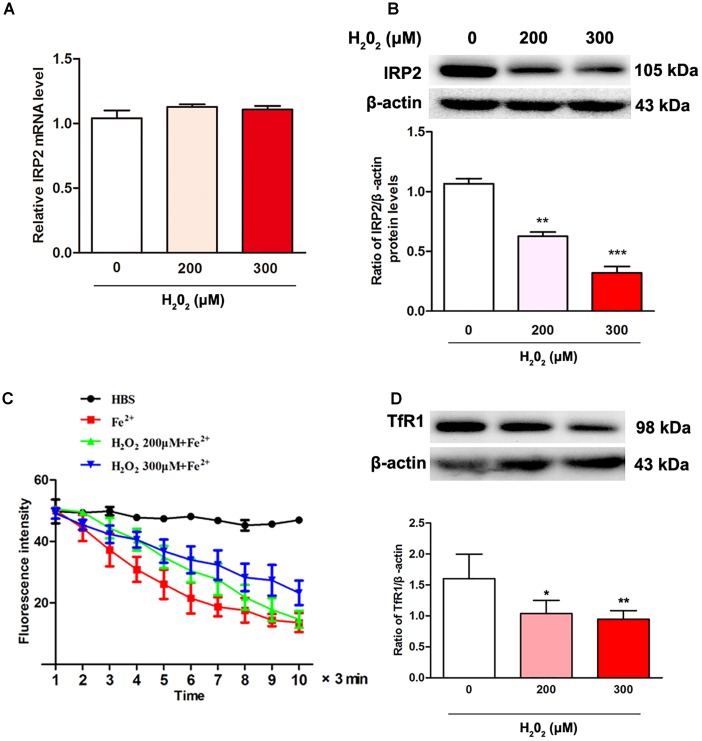
H2O2 induced the changes in IRP2 levels and ferrous iron uptake in SH-SY5Y cells. (A) IRP2 mRNA levels were changed with H2O2 treatment. One-way ANOVA, data were presented as mean ± SEM of 3 independent experiments. (B) IRP2 protein levels were changed with H2O2 treatment. One-way ANOVA, data were presented as mean ± SEM of 3 independent experiments.∗P < 0.05, ∗∗P < 0.01, and ∗∗∗P < 0.001 compared with H2O2 0 μM group. (C) Calcein-indicated ferrous iron (FeSO4) influx in SH-SY5Y cells. The fluorescence intensity of SH-SY5Y cells in 200 μM group and 300 μM group were significantly higher than that in 0 μM H2O2 group. Two-way ANOVA, ∗P < 0.05. The mean fluorescence intensity of 35 separate cells from 4 separate fields at each time point was presented as mean ± SEM of 6 independent experiments. (D) TfR1 protein levels were changed with H2O2 treatment. One-way ANOVA, data were presented as mean ± SEM of 3 independent experiments.∗P < 0.05 and ∗∗P < 0.01compared with H2O2 0 μM group.